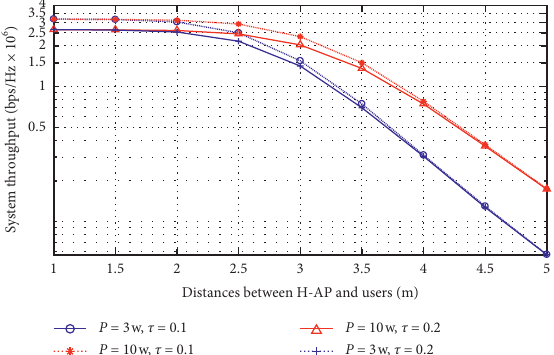
Figure 5: The relationship between the distance from user to the H- and the system throughput with L � 8, N � 2, σ 2 � − 50dBm/Hz, and η � 0 . 8.